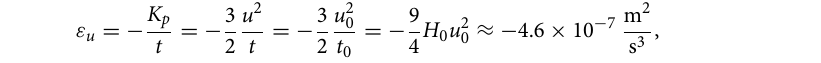
ε u t . The proportional constant ε u is estimated in Eq. a 3 / 2 ∝ ∝